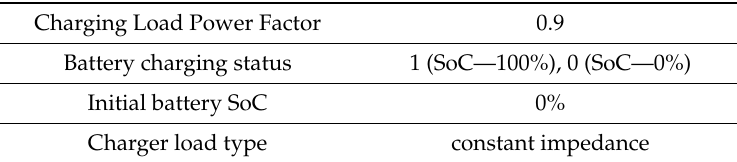
Table 2. Battery electric vehicle (BEV) parameters.